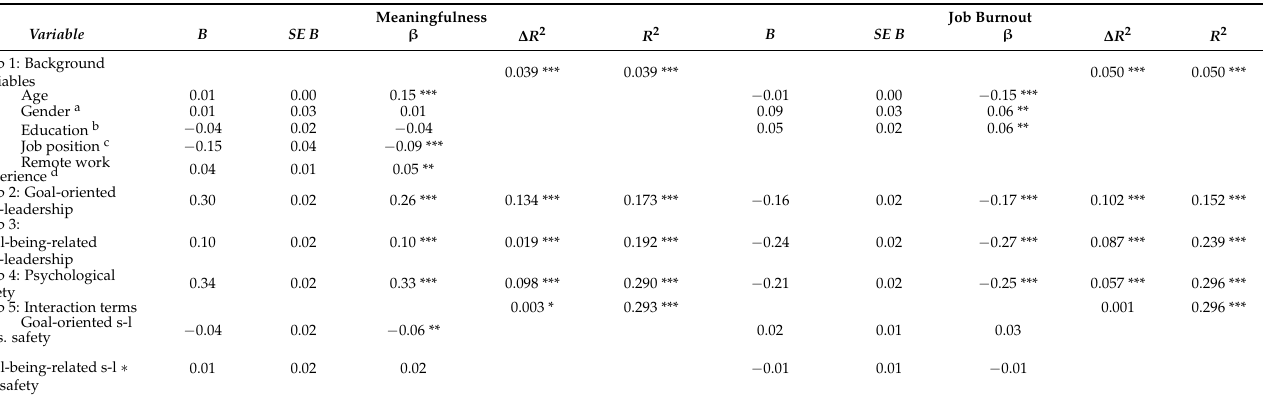
Table 2. Results of Multiple Regression Analyses with Meaningfulness and Job Burnout as Depen- dent Variables.